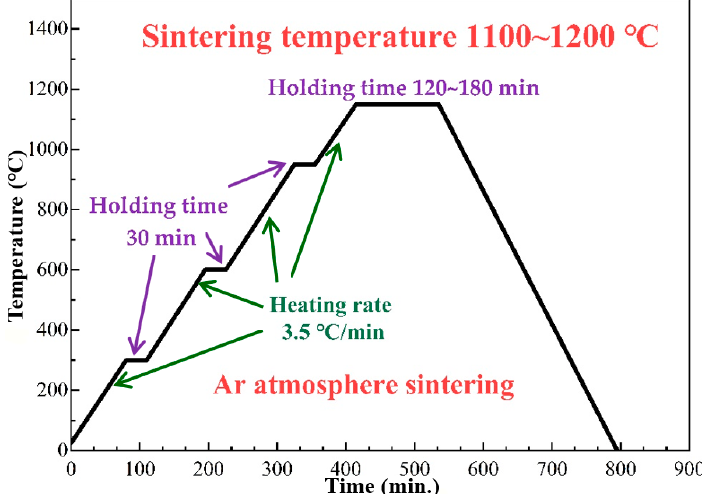
Figure 2. The schematic diagram of heating cycle for sintering SSF samples.